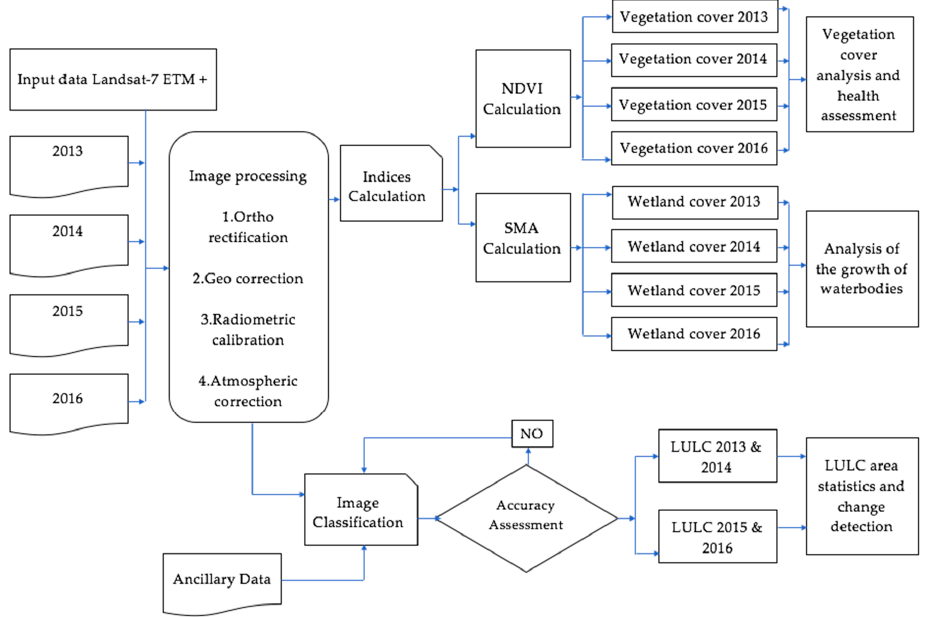
Figure 3. Methodology for the analysis of landscape dynamics and vegetation health (productivity) (NDVI: Normalized Difference Vegetation Index; ETM: Enhanced Thematic Mapper; SMA: Spectral Mixture Analysis; LULC: Land-use and Land cover).